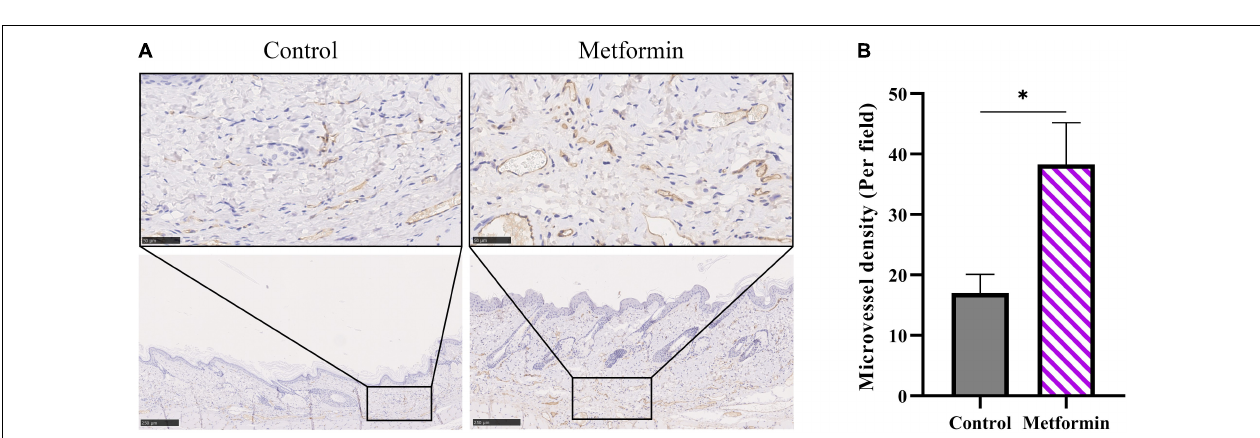
FIGURE 6 | Detection of microcirculatory blood flow. (A) Microcirculatory blood flows analysis of mechanically stretched skin from the metformin-treated and control groups. (B) The results showed significantly increased blood flow in the metformin-treated group and (C) a higher number of blood vessels observed in freshly isolated skin from the metformin-treated group relative to the control group. ∗ p < 0.05.